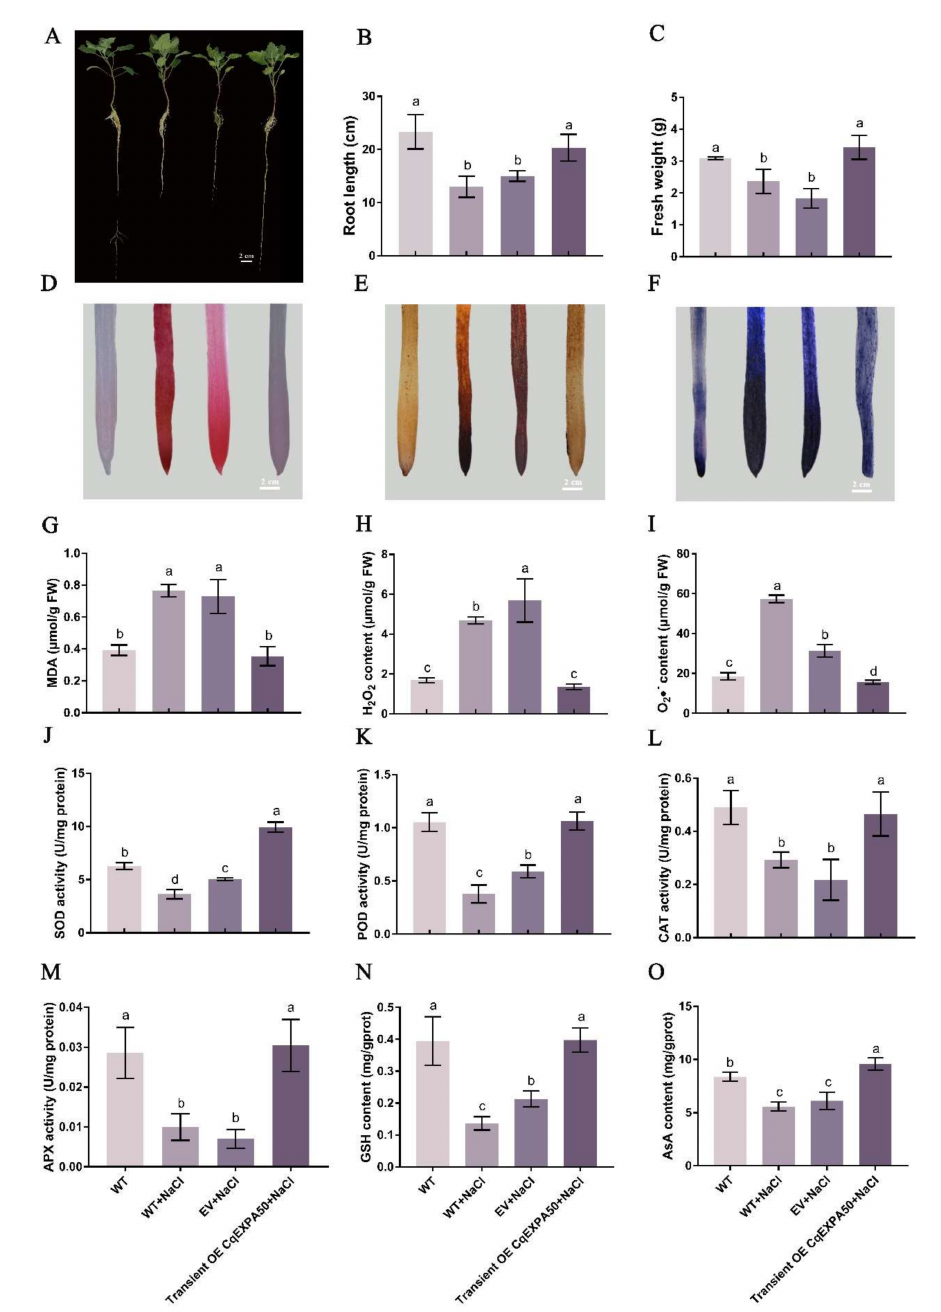
Figure 4. Effects of CqEXPA50 on the growth and antioxidant capacity of quinoa roots under salt stress. The phenotype, root length and fresh weight of all these quinoa seedlings in different treatments were recorded. ( A ) Phenotypic changes in quinoa seedlings under different treatments. Bar = 2 cm. ( B ) The root length. ( C ) The fresh weight. ( D ) MDA staining results under different treatments. The redder the color, the greater the MDA content. Bar = 2 cm. ( E ) H 2 O 2 staining results under different treatments. The browner the color, the greater the H 2 O 2 content. Bar = 2 cm. ( F ) O 2 • − staining results under different treatments. The bluer the color, the great the O 2 • − content. Bar = 2 cm. ( G ) MDA content in roots. ( H ) H 2 O 2 content in roots. ( I ) O 2 • − content in roots. ( J ) SOD activity. ( K ) POD activity. ( L ) CAT activity. ( M ) APX activity. ( N ) GSH content. ( O ) ASA content. Values are the mean ± SD ( n = 3). Different letters (a–d) in Figure 4 indicate significant differences at p < 0.05 according to one-way ANOVA (comparing the mean of each column with the mean of every other column) in GraphPad Prism